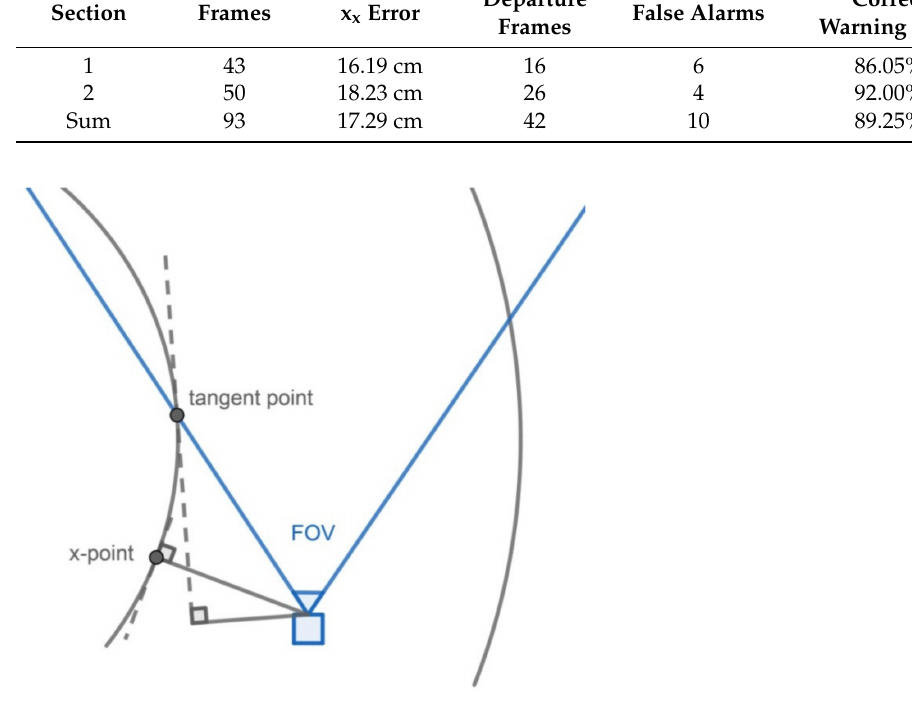
Figure 16. The position of